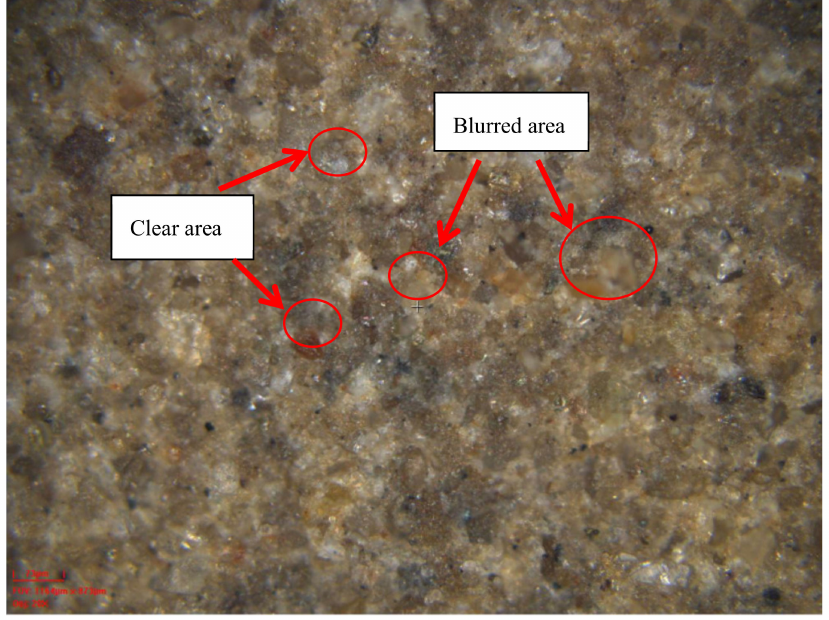
Figure 5. The scanned image at a specific height.